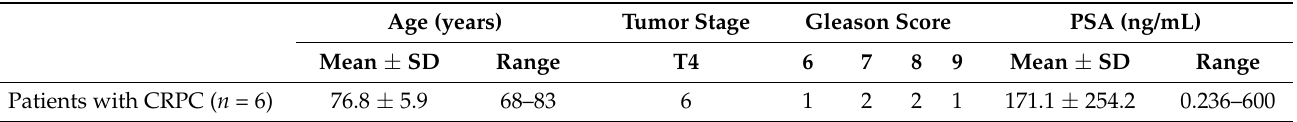
Table 1. Demographic and clinicopathological characteristics of castration-resistant prostate cancer patients recruited to the study.